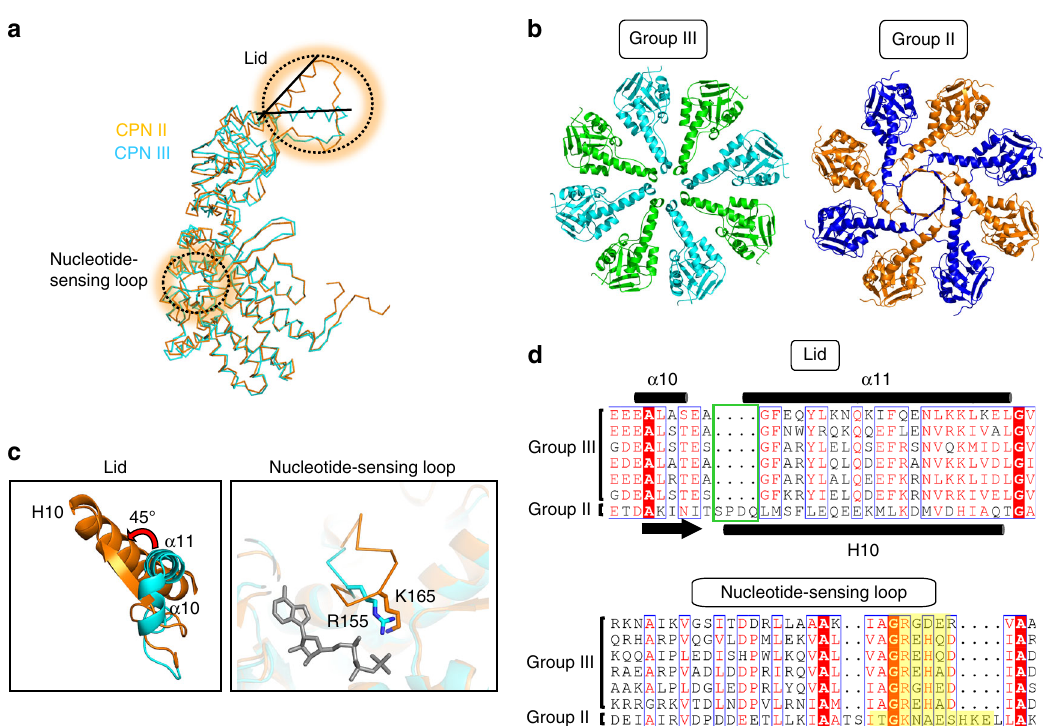
Fig. 5 Comparison of Ch-CPN with Group II CPN. a Superposition of subunit structures of Ch-CPN (cyan) and Group II TKS1-CPN (PDB entry: 1Q3S 31 , orange). Signi fi cantly different regions between Group II and III CPNs are indicated by dotted circles. b Top views of the lid of Group II (right) and Group III CPNs (left). c Close-up views of the lid (left) and nucleotide-sensing loop (right) regions of Group II and III CPNs. The lid of TKS1-CPN (orange) is rotated 45° relative to Ch-CPN (cyan). In the nucleotide-sensing loop, Arg155 of Group III CPN (cyan) is equivalent to Lys165 (orange) in Group II. Bound AMPPNP is shown in a gray stick. d Structure-based sequence alignments of the lid (upper) and nucleotide-sensing loop (bottom) in Group II and Group III CPNs. Deletions in the lid of Group III CPNs are indicated by a green box (upper). Residues constituting nucleotide-sensing loops are highlighted in yellow backgrounds